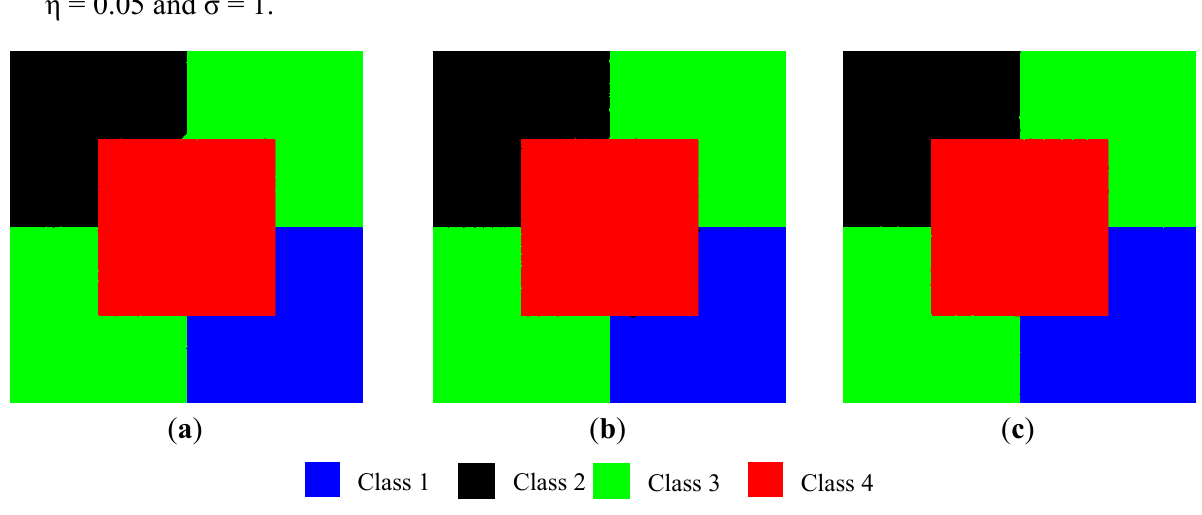
Figure 7. Examples of the resulting LCMs from our proposed algorithm ( a ) Scenario I with δ = 12 and σ = 1; ( b ) Scenario II with ρ = 0.05 and σ = 1; and ( c ) Scenario III with η = 0.05 and σ = 1.